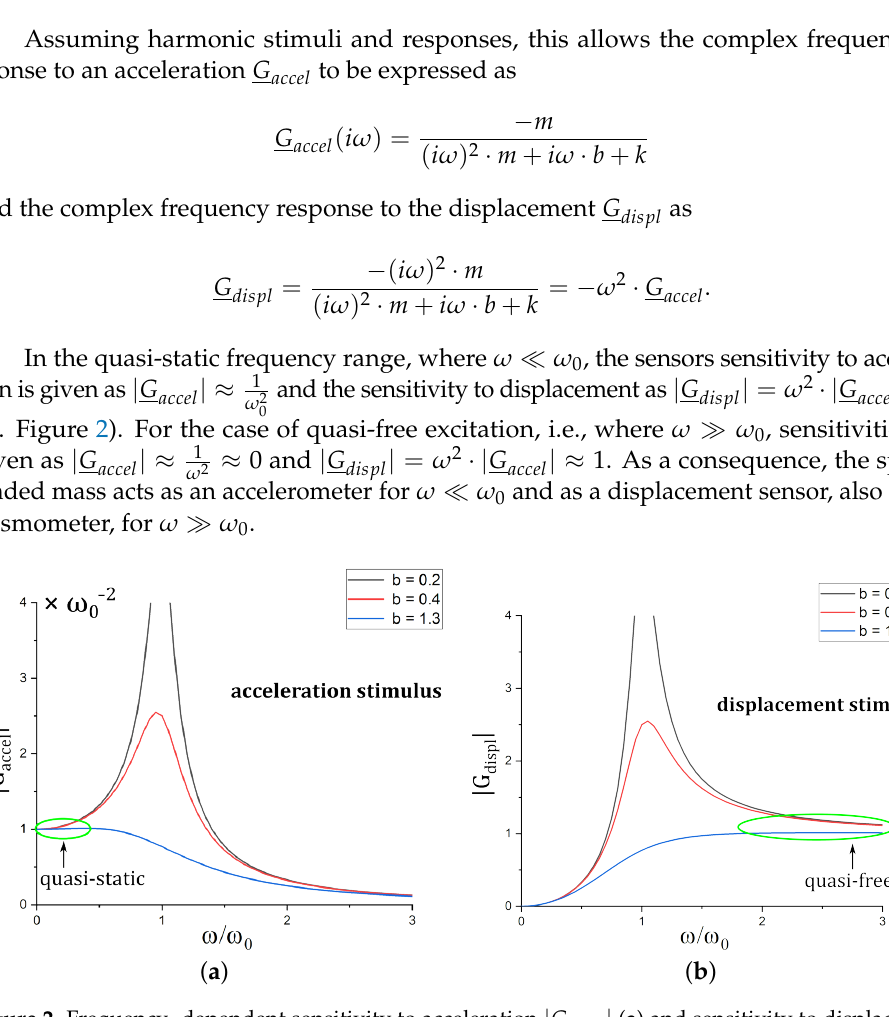
Figure 2. Frequency -dependent sensitivity to acceleration | G accel | ( a ) and sensitivity to displacement | G | ( b ). The colors indicate different levels of displ